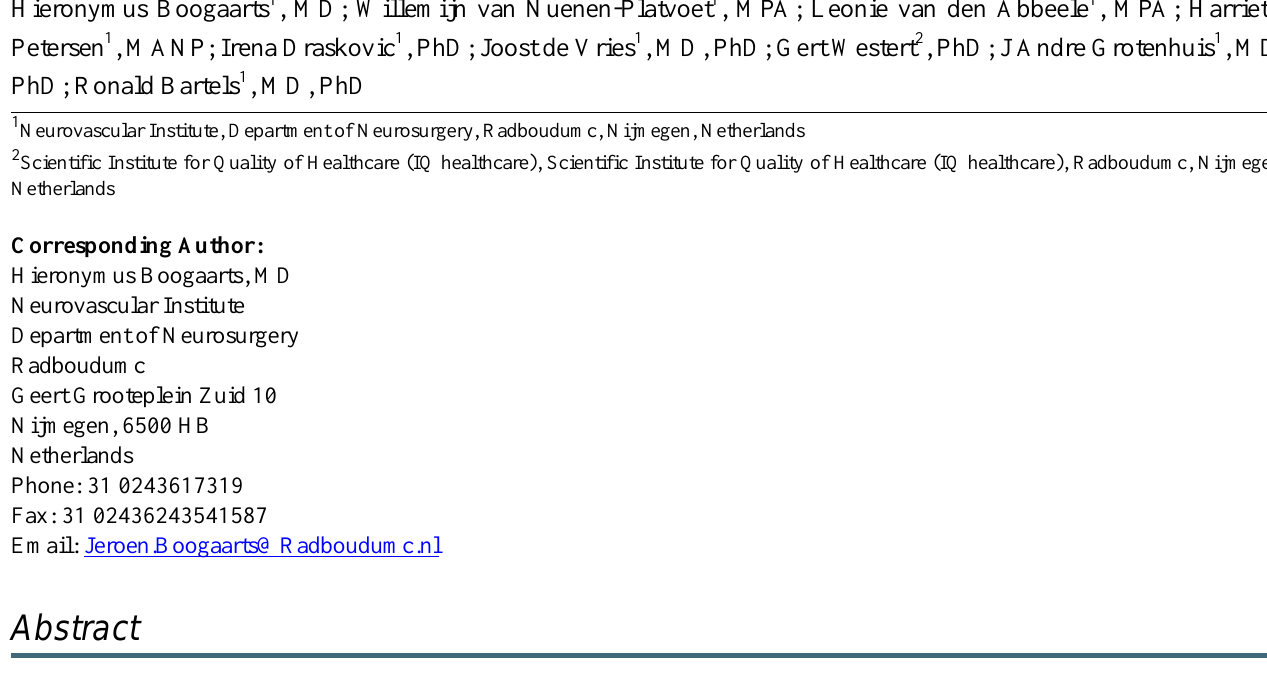
subarachnoid hemorrhage; online community; quality of